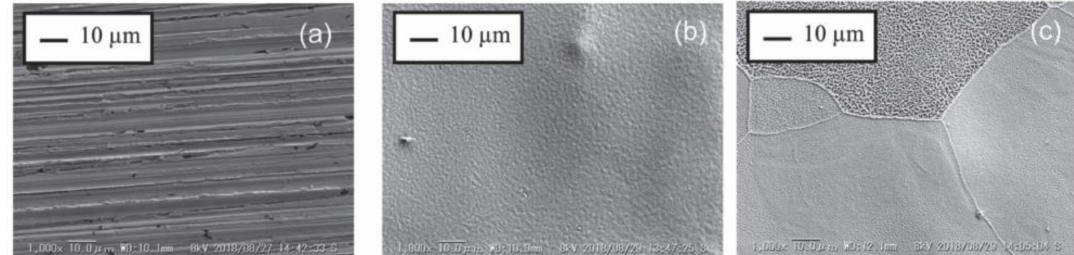
Figure 13. SEM images of an Sn electrode before ( a ) and after ( b , c ) potentiostatic anodization in BMPNTf 2 at 0.1 V (Ag/Ag + ) with stirring at 1200 and 1500 rpm (25 ◦ C); current density 14.3 ( b ) and 29.1 C cm − 2 ( c ) (reprinted with permission from ref. [53]; Copyright 2021 the author(s), published on behalf of The Electrochemical Society by IOP